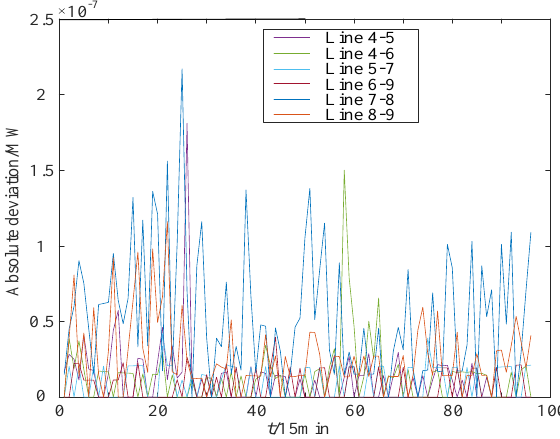
Figure 7. Absolute deviation between the values of the two sides of quadratic equality (25) on different lines.